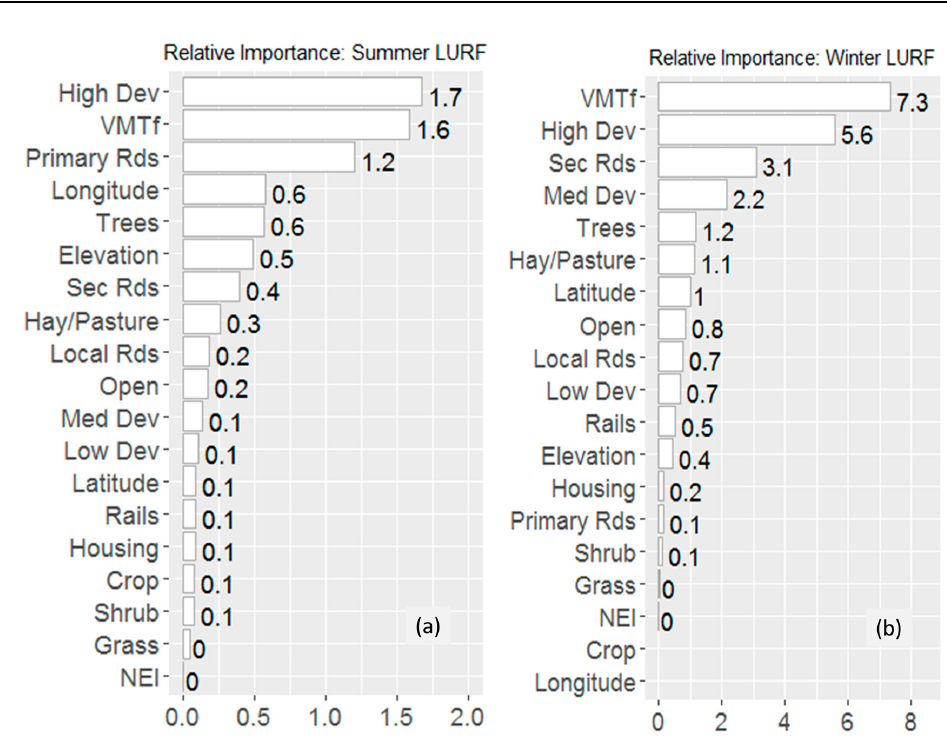
Figure 3. Relative importance of the LULC predictors ( a ) in the summer and ( b ) winter LURF